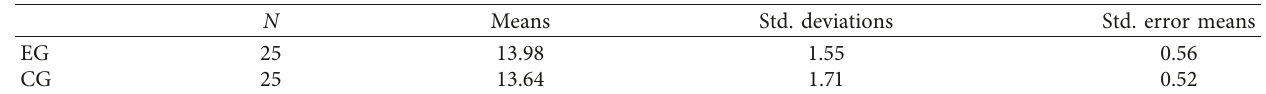
Table 6: DS of motivation pretest.